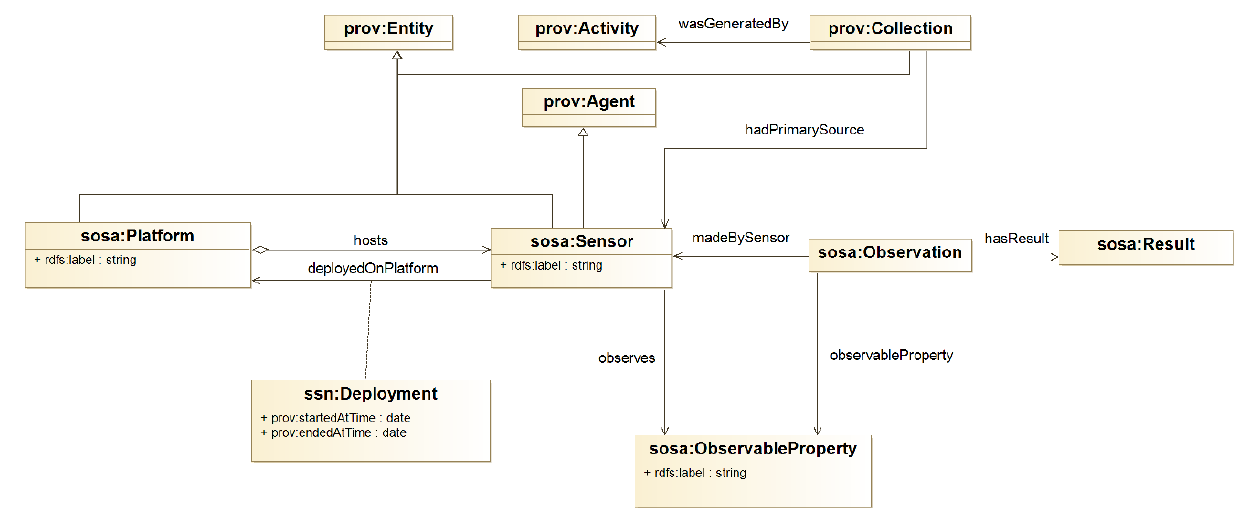
Figure 1. Contextualising measurements using PROV-O and